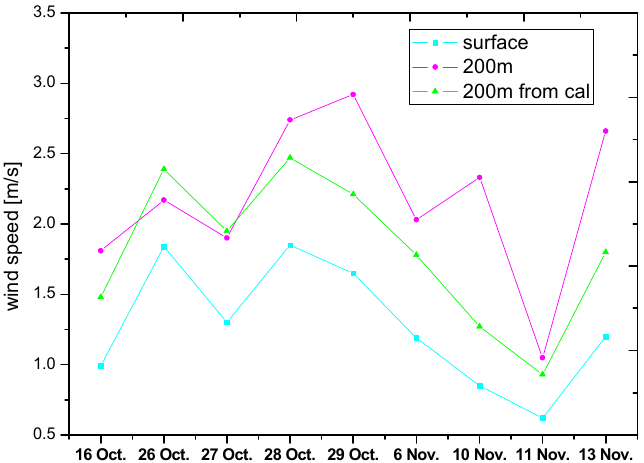
Figure 7. Three types of wind speed. Blue indicates the wind speed source from ground-based wind; pink indicates the wind speed source from 200 m height (LIDAR or model); and green indicates the wind speed source from 200 m height with calculation from ground-based wind.